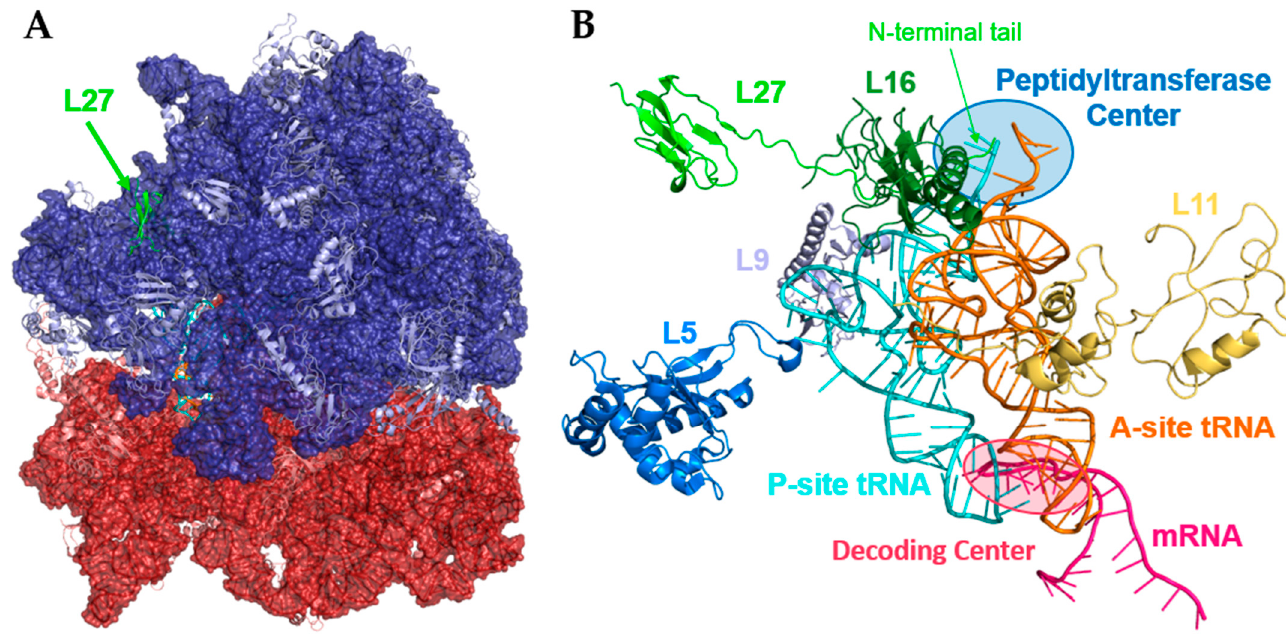
Figure 1. Ribosomal protein L27. ( A ). Ribosomal proteins (RPs) in E coli . The large subunit (50S, blue) is made of rRNA (dark blue) and 34 RPs (light blue). The small subunit (30S, red) contains rRNA (red) and about 21 RPs (salmon). L27 (green) is mainly located in the 50S ribosomal subunit (blue) but has an N-terminal tail that reaches the peptidyltransferase center (PTC) at the interface between the 50S and 30S (red) subunits. ( B ). Large subunit-associated RPs directly interacting with tRNA. This includes L27’s N-terminus (green) stabilizing the 3 ′ ends of tRNA in both the A-site (orange) and P-site (cyan). PDB code: 4V6F. All images produced with PyMOL Molecular Graphics System, Version 2.0 Schrödinger, LLC.